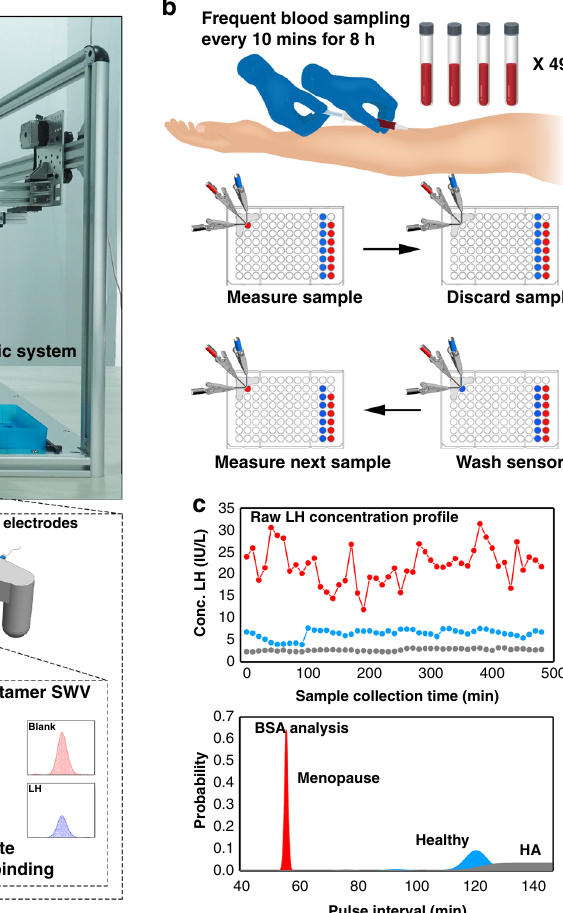
Fig. 1 Overview of the Robotic APTamer-enabled electrochemical reader (RAPTER). a RAPTER design. RAPTER consists of a potentiostat, laptop interface, open-source liquid-handling robot and the 96-well-plate sensing platform. The quanti fi cation of the LH level is achieved by analysing the electron transfer kinetic changes (interrogated via square-wave voltammetry (SWV)) upon binding of LH under a three microwire electrode system held within a 3D-printed holder. b A series of samples can be loaded onto the 96-well platform, and the measurement process can be automated by the programmable liquid- handling robot. Serum samples collected from frequent blood sampling analysed by the immunochemical test (antibody test) were used as a comparison with test RAPTER performance in measuring LH concentration in human clinical samples. c The time-course data (LH concentrations at 10-min intervals